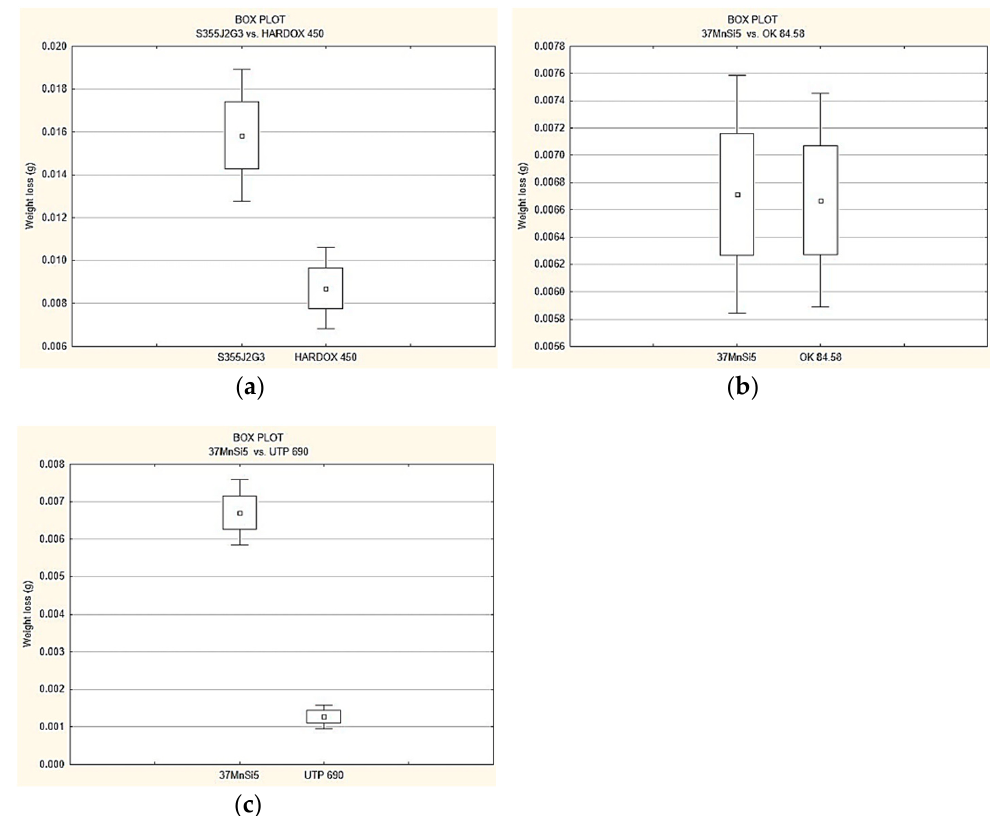
Figure 11. Box charts: ( a ) weight loss of S355J2G3 and HARDOX 450 materials; ( b ) weight loss of 37MnSi5 material and OK 84.58 hardfacing material; and ( c ) weight loss of 37MnSi5 material and UTP 690 hardfacing material.